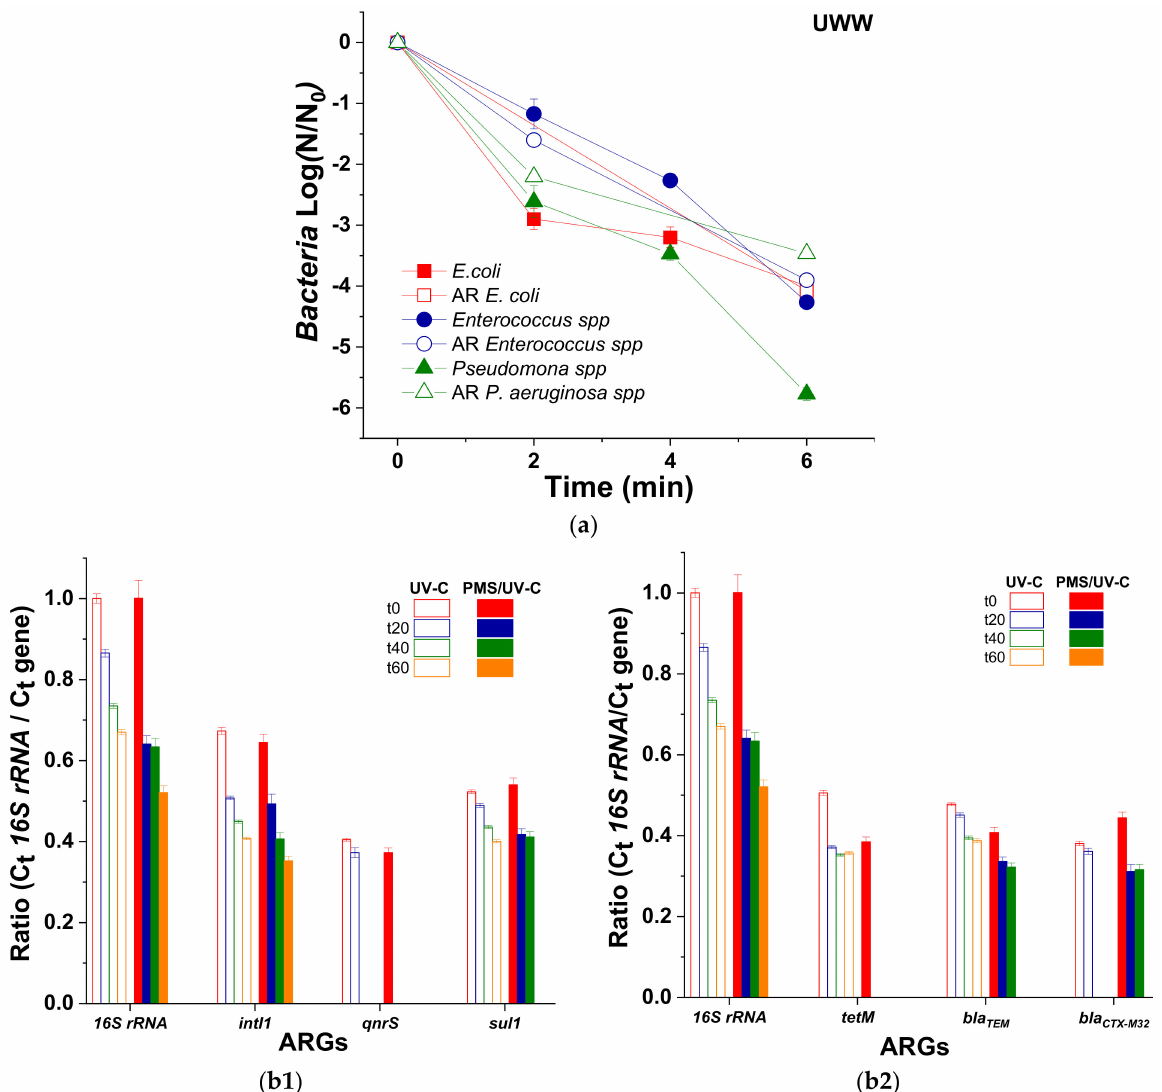
Figure 3. ( a ) Inactivation of E. coli , Enterococcus spp., and Pseudomonas spp. and their Ampicillin (AMP), Ciprofloxacin (CPX) and Trimethoprim (TMP) antibiotic-resistant counterpart and ( b1 , b2 ) relative abundance of each ARG (with respect to 16S rRNA ) as a function of time under UV-C irradiation in the absence and in the presence of PMS (1